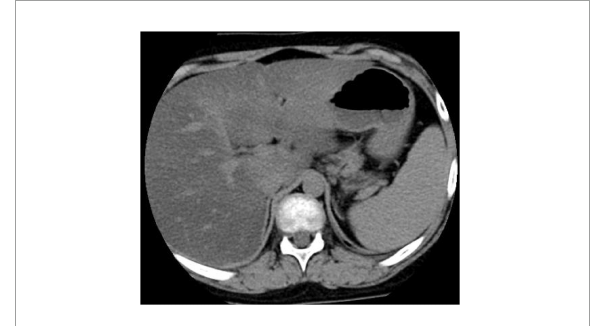
FIGURE2 Computed tomography (CT) scan of the adrenal gland showed nodular thickening of the left adrenal junction of patient 4.